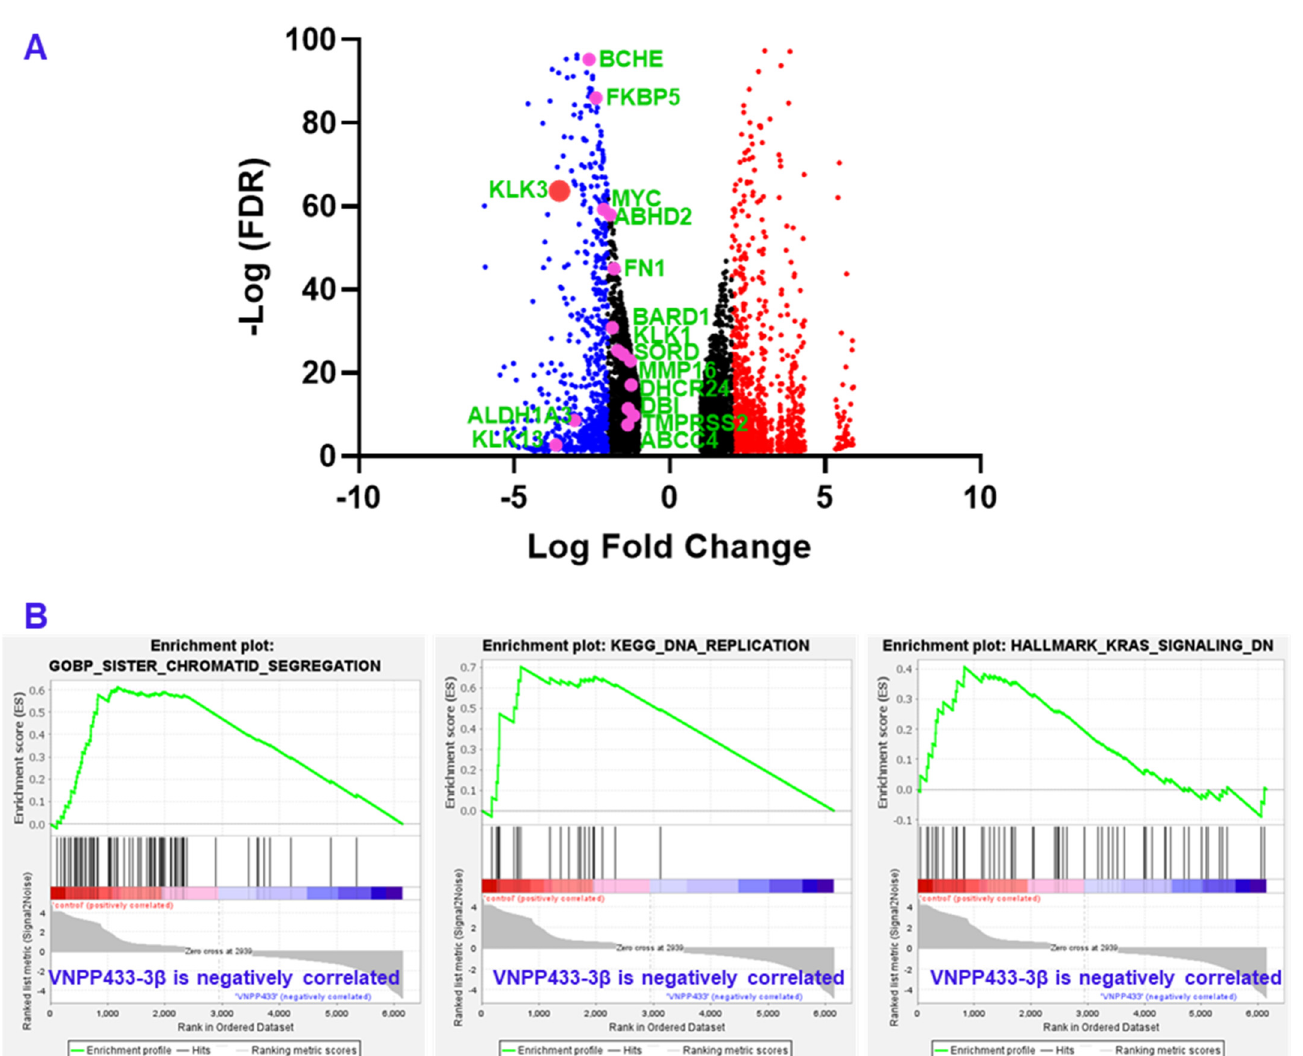
Figure 5. RNA sequencing and gene expression analysis shows that several androgen-responsive genes that are transcriptional target of AR are significantly downregulated including KLK3 that encodes prostate specific antigen (PSA). ( A ) Volcano plot of differentially expressed genes upon treating CWR22Rv1 cells with VNPP433-3 β for 24 h. Key AR target genes are highlighted as pink dots labeled in green and presented in Table 1. Prostate specific antigen (PSA) or KLK3 is represented as large red dot. Blue and small red dots indicate downregulated and upregulated genes respectively. Black dots represent genes that are down or upregulated less than two LFC. ( B ) The Gene Set Enrichment Analysis (GSEA) plot showing inhibition of pathways (sister chromatid segregation, DNA replication and KRAS signaling) critical to prostate cancer development and progression. Table 1. The genes that are transcriptional targets of AR [29] found to be downregulated upon in tumorigenesis.